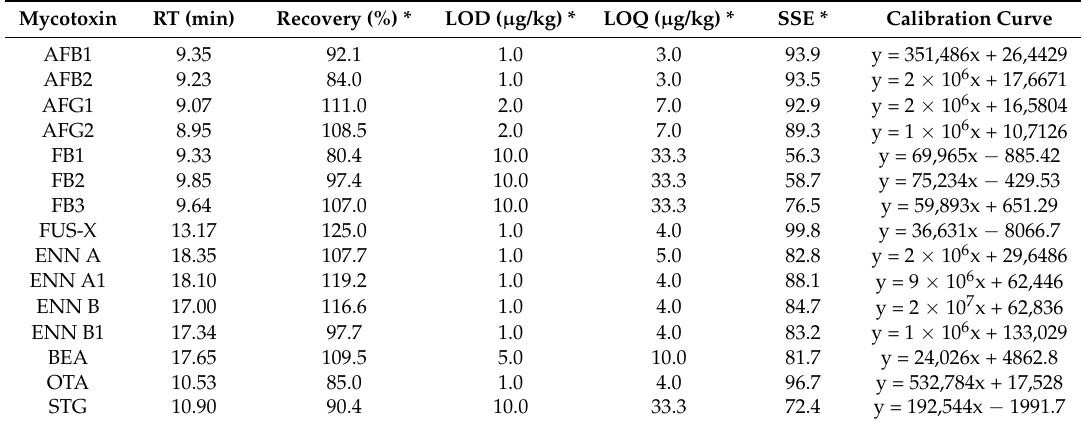
Table 2. Retention time (RT), recovery, limits of detection (LOD) and quantitation (LOQ), matrix effect (expressed as SSE), and calibration curves for each analyzed